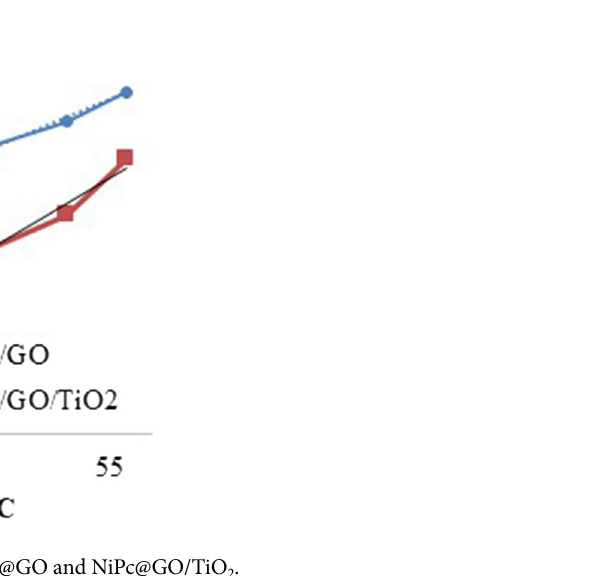
Figure 7. Temperature effect on NiPc@GO and NiPc@GO/TiO 2